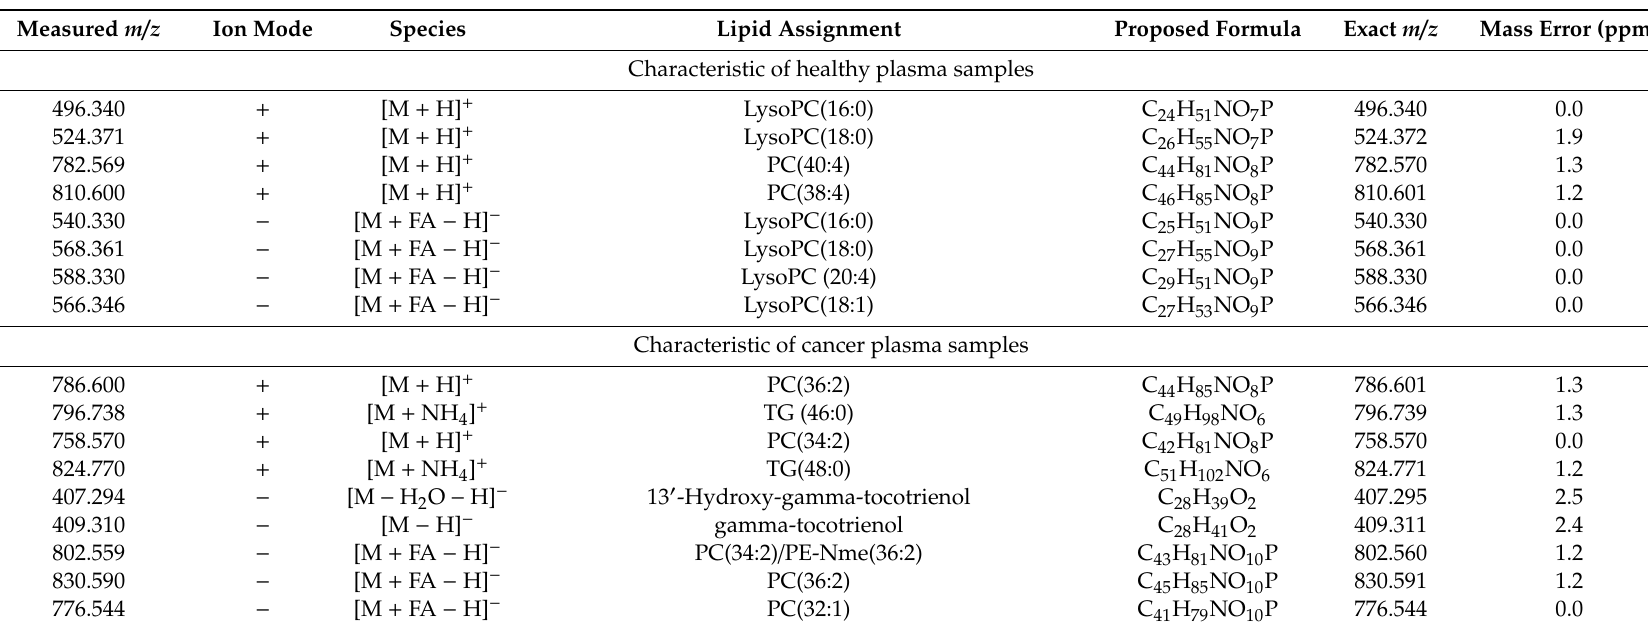
Table 1. Discriminant ions selected by Supporting Vector Machine (SVM) models (positive and negative ion mode) as significant contributors to the molecular classification of plasma from healthy and cancer